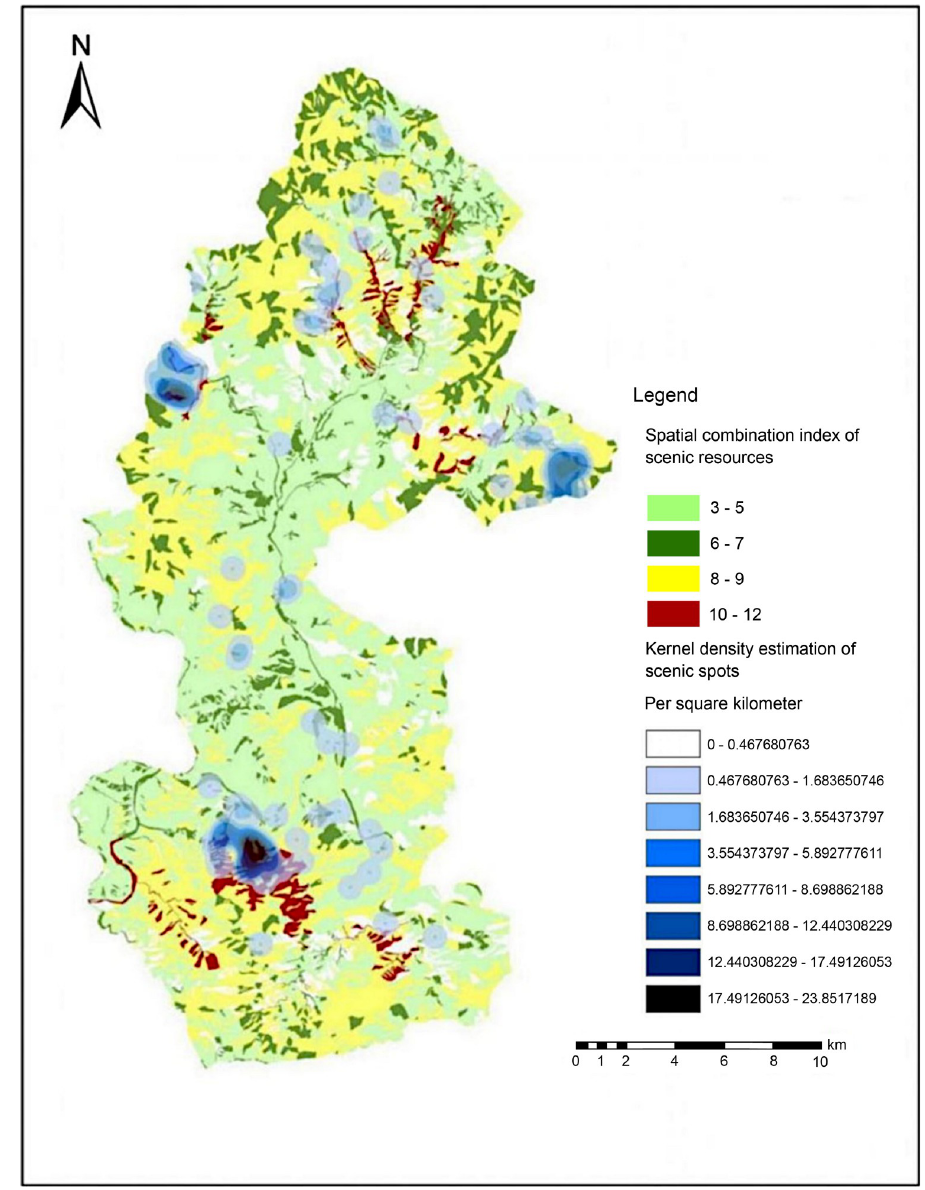
Fig 7. Overlay analysis chart of SCISR and KDE of scenic resources in the Yesanpo National Park. (Republished from [https://directory.eoportal.org/web/eoportal/satellite-missions/g/gaofen-2] under a CC BY license,